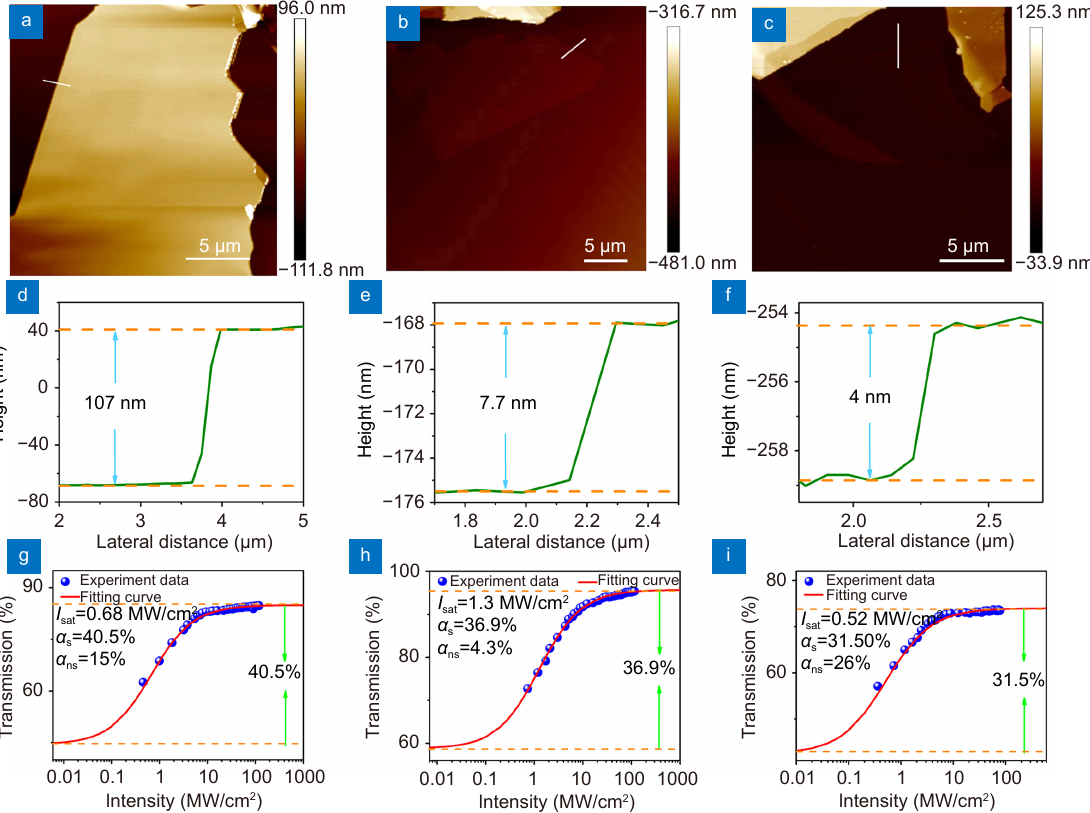
Fig. 1 | Characterization of materials. The AFM image, thickness and nonlinear absorption of ( a, d, g )107 nm-SnS 2 SA, ( b, e, h )7.7 nm-SnS 2 SA, ( c, f, i )4 nm-SnS 2